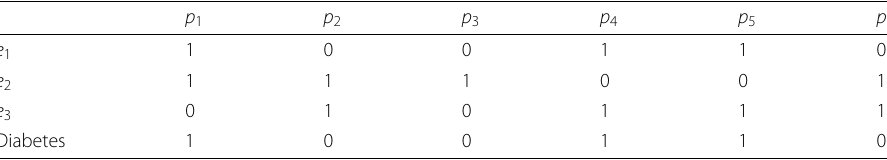
Table 2 Tabular representation of the soft set F A p 1 p 2 p